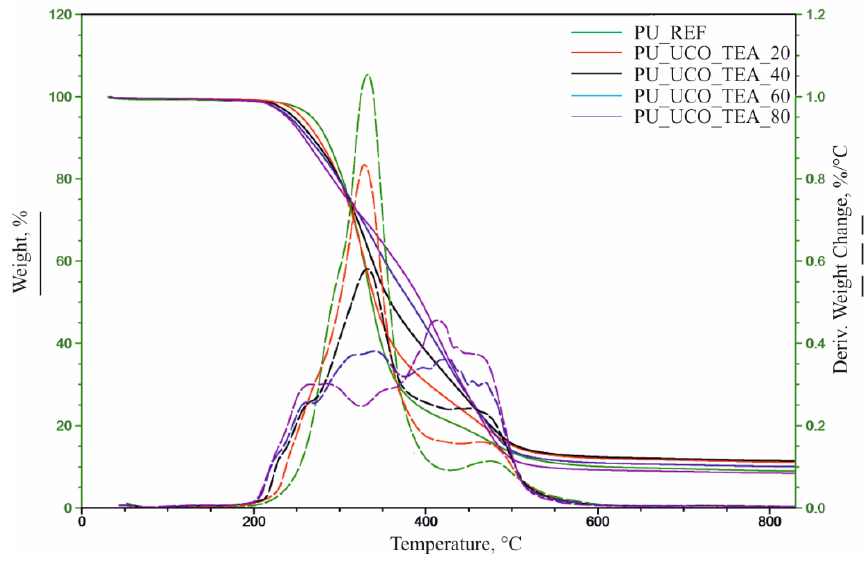
Figure 9. Thermograms for reference material and PU_UCO_TEA foams.